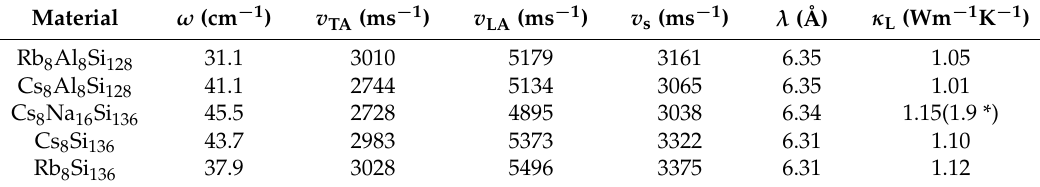
Table 2. Local density approximation (LDA)-performed rattling mode ω , group velocity of